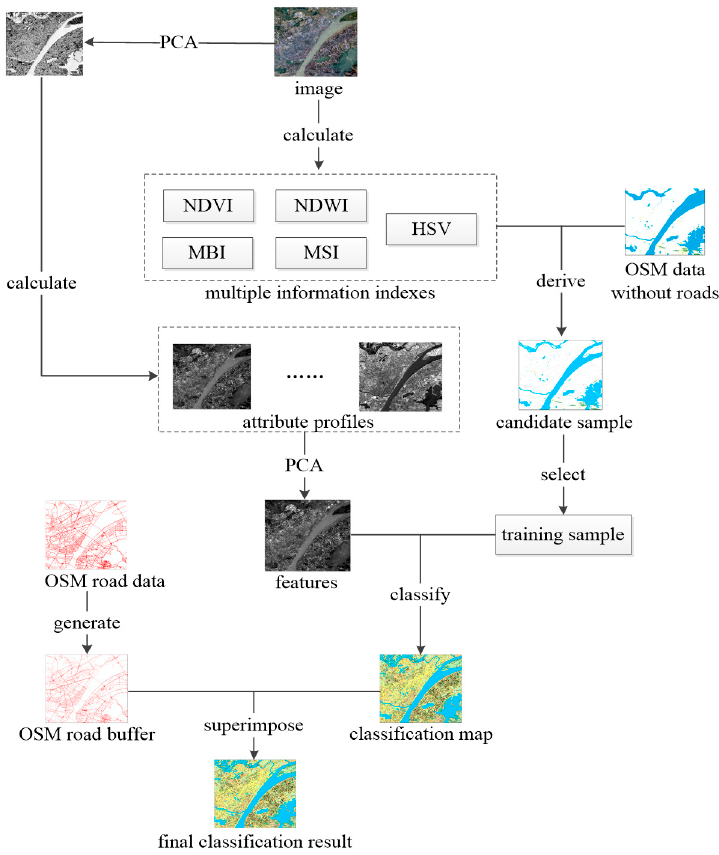
Figure 1. Flowchart of the proposed framework.